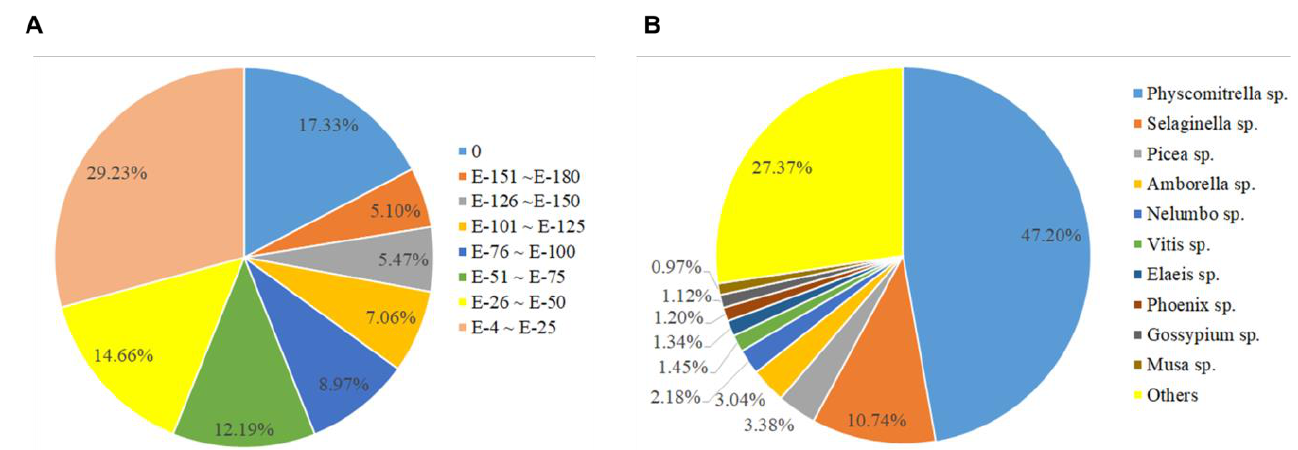
Figure 3. E-value distribution of the top five BLASTx hits for each unigene (less than 1.0 × 10 − 4 ) ( A ) and Nr annotation species distribution analysis ( B ).